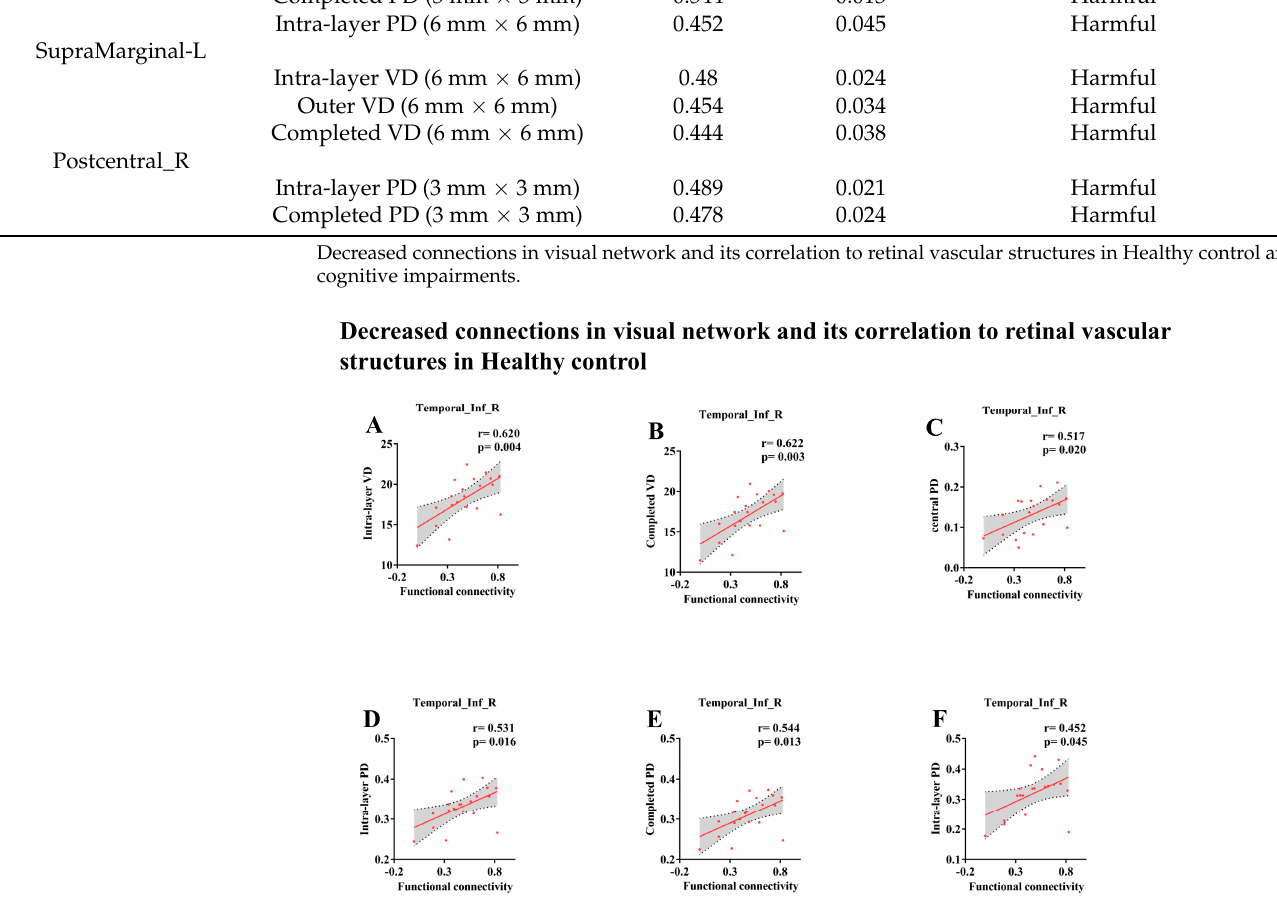
Table 4. Correlative analysis between FC changes and structural changes of the fundus of HC and CI subject.